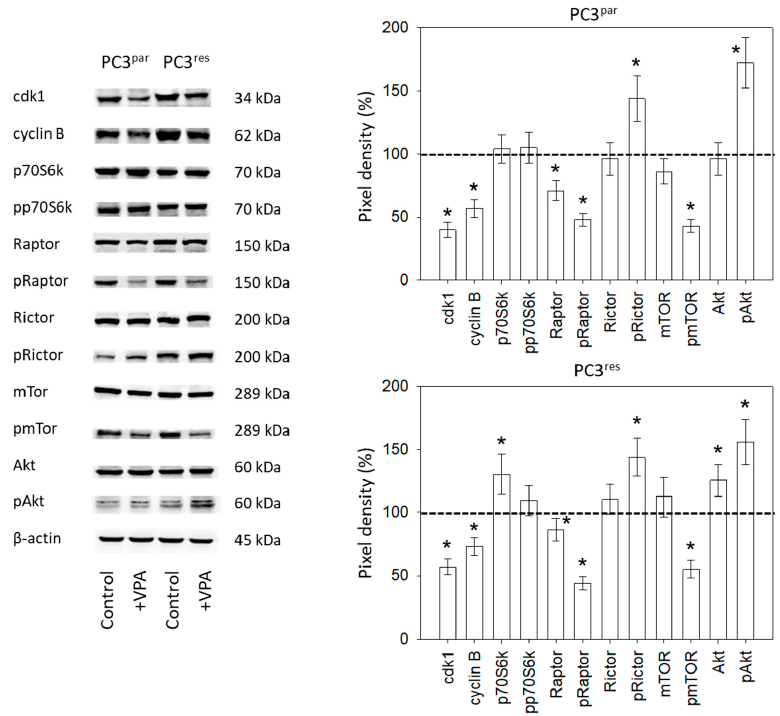
Figure 5. Protein expression profile of cell cycle-regulating and targeted proteins in PC3 par and PC3 res cells after three days exposure to VPA (1 µmol/mL) and untreated controls. β -actin served as the internal control. * indicates significant difference to untreated control cells.